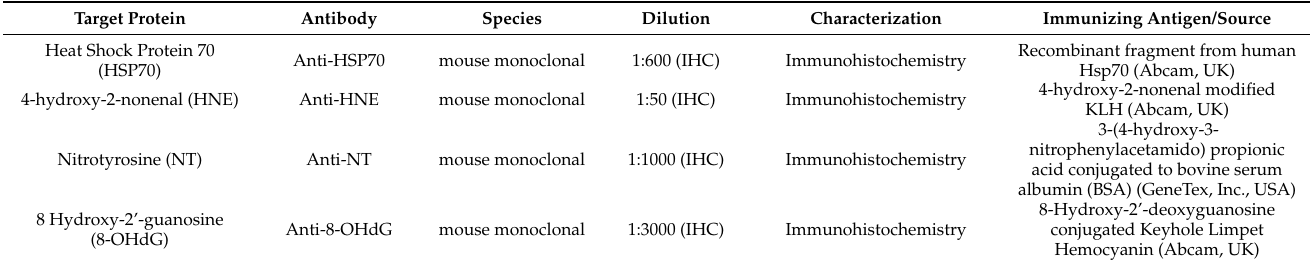
Table 1. Primary antibodies